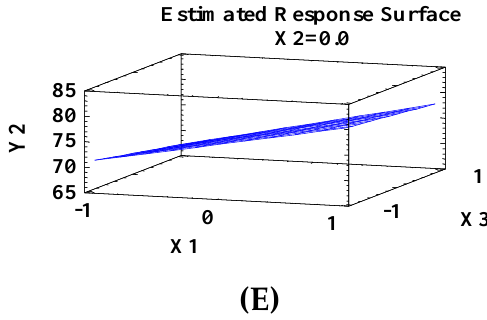
Figure 2. The effect of independent variables on the vesicle size (Y2) including the Pareto chart ( A ), main plot effect ( B ), and three-dimensional contour plots ( C – E ).